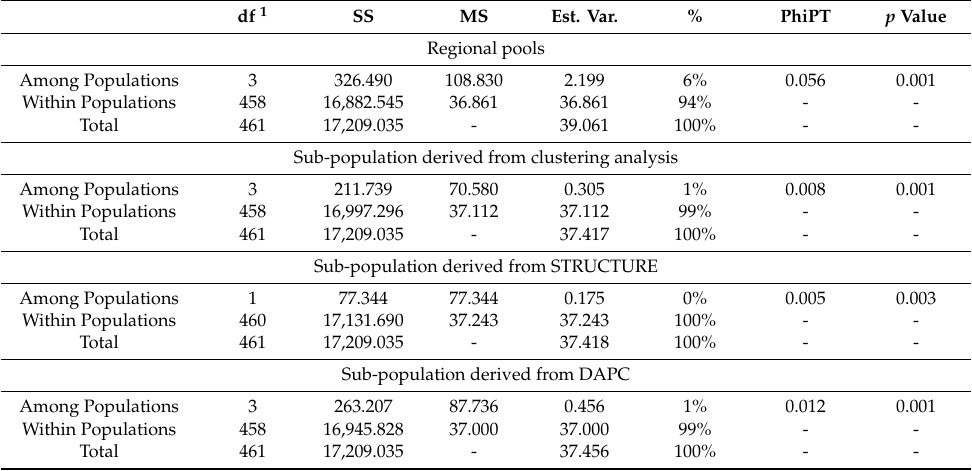
Table 5. Analysis of the molecular variance (AMOVA) among and within populations in the regional pools and sub-populations derived from the clustering analysis, STRUCTURE, and DAPC. df 1 SS MS Est. Var. % PhiPT p Value Regional pools